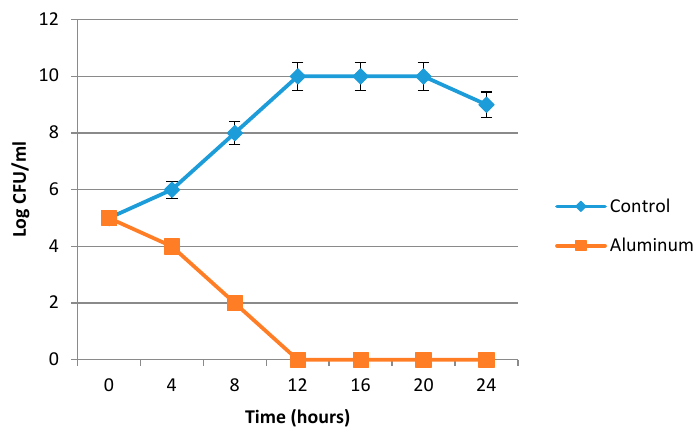
Figure 2. Lethality curve of A. baumannii upon treatment with γ -Al 2 O 3 NPs.